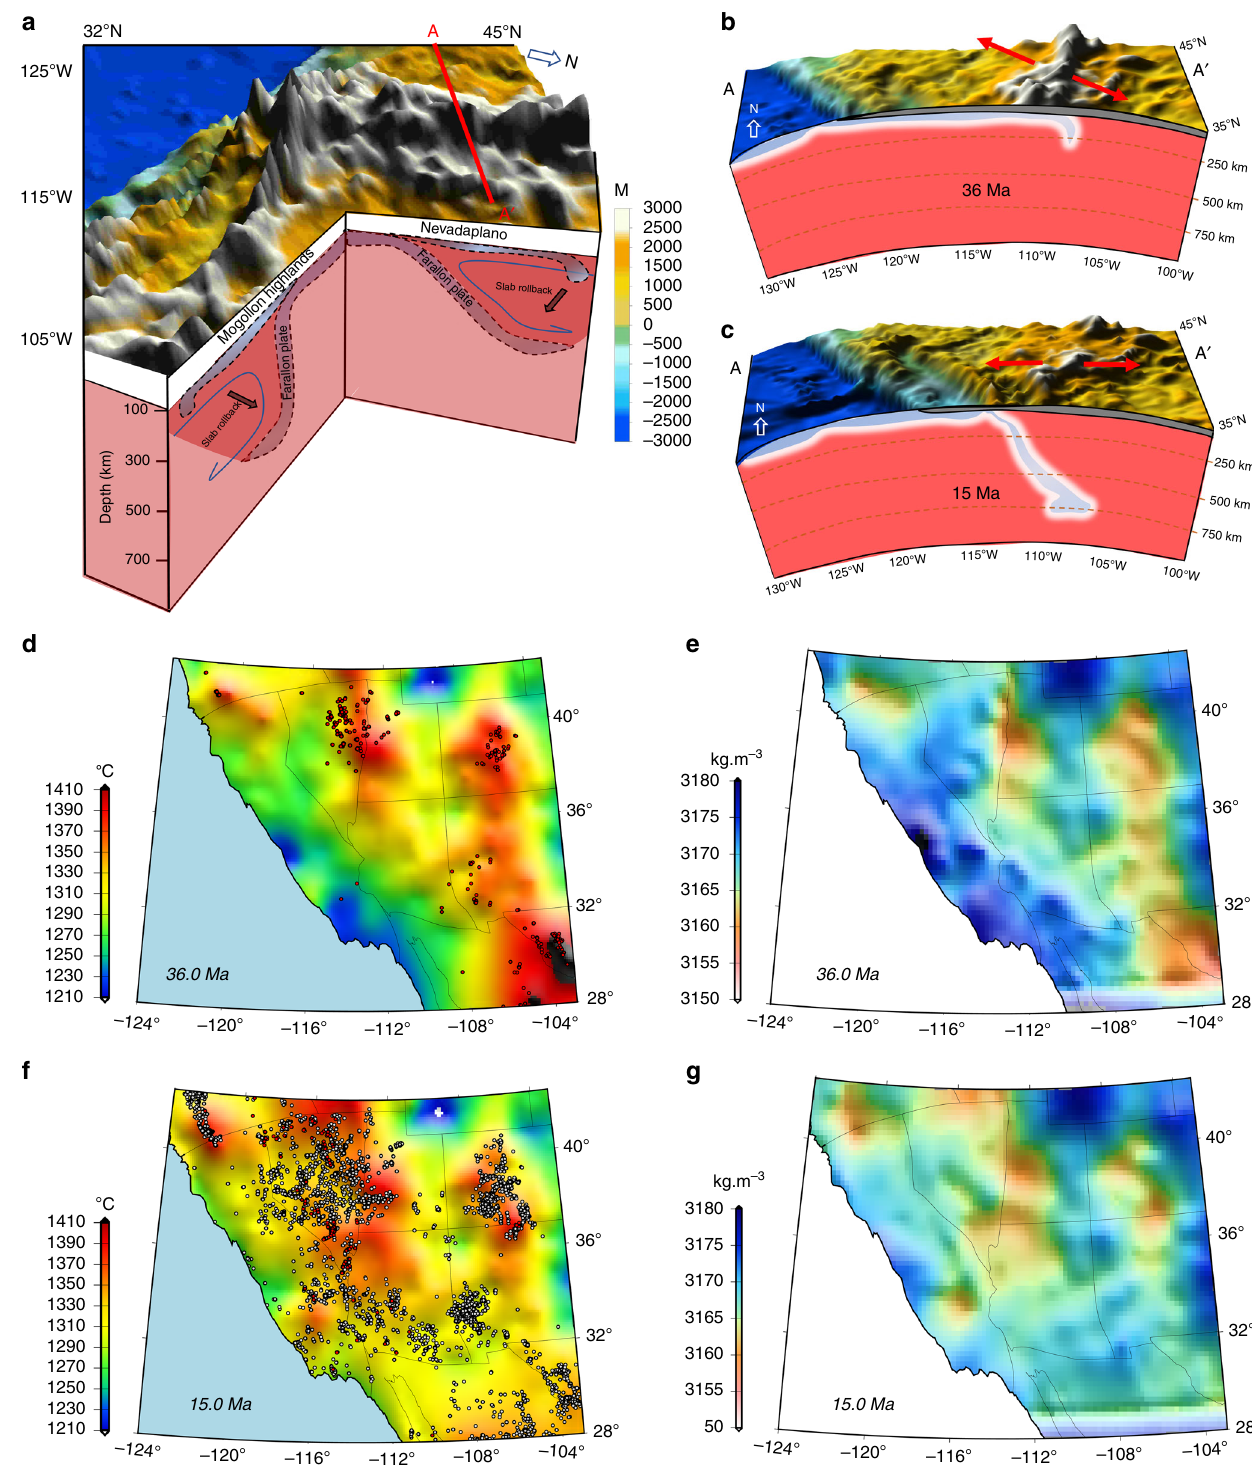
Fig. 6 Role of Farallon slab rollback on ignimbrite fl are up, upper mantle density variation, and landscape evolution. a 3-D perspective image of paleo- elevation of Nevadaplano and Mogollon Highlands at 36 Ma from model of Bahadori et al. 8 along with development of slab rollback. b , c Progressive slab tearing at latitude 41°N at Late Eocene (36 Ma) and Middle Miocene (15 Ma) from Liu and Stegman 17 underneath the Nevadaplano from model of Bahadori et al. 8 . Red arrows show general directions of deviatoric tension obtained in dynamic model that incorporates body forces (gradients in GPE) and velocity boundary conditions. d , f Maps of averaged upper mantle temperature from Moho boundary to 100 km depth. Red and grey dots represent reconstructed coordinates of present-day localities of paleo-magmatism through time. Red dots represent active magmatism and grey dots represent previously active magmatism. e , g Maps of upper mantle density changes inferred from models of lithospheric pressure, upper mantle temperature, and volumetric degree of melting for upper mantle